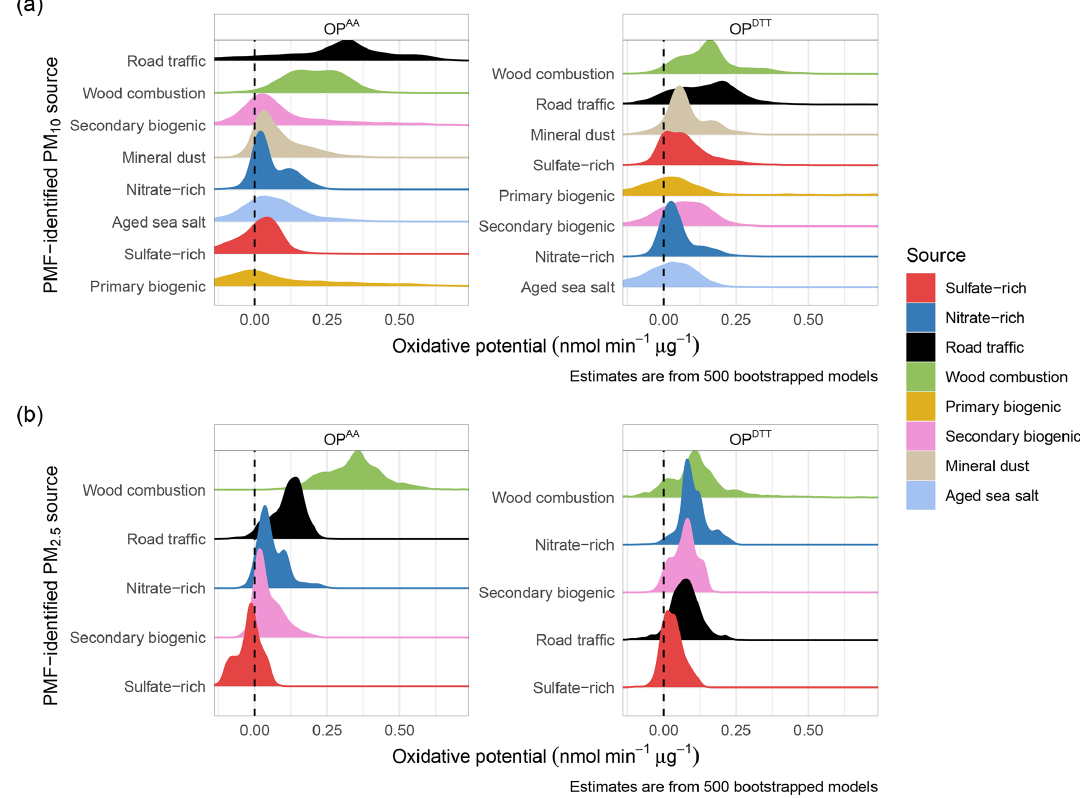
Figure 4. Densities of the intrinsic OP mAA (a) and OP mDTT (b) estimates for the eight PM 10 and five PM 2 . 5 PMF-identified sources. The estimates for all five sites included in the analysis have been